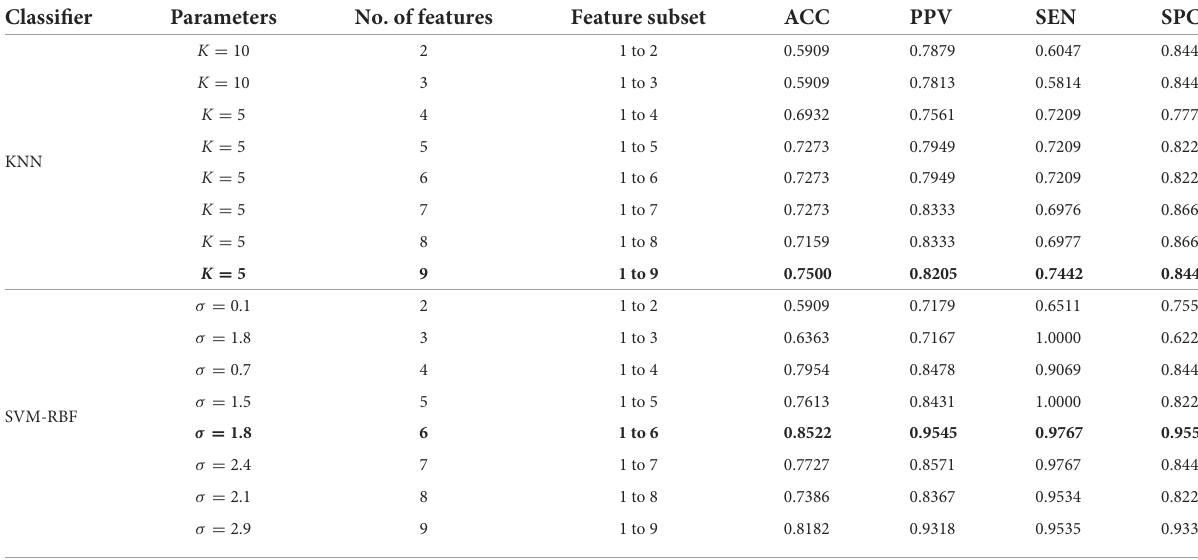
TABLE 4 MDDSI classification tests results using KNN and SVM-RBF classifiers with features from the 3 physiological signals.